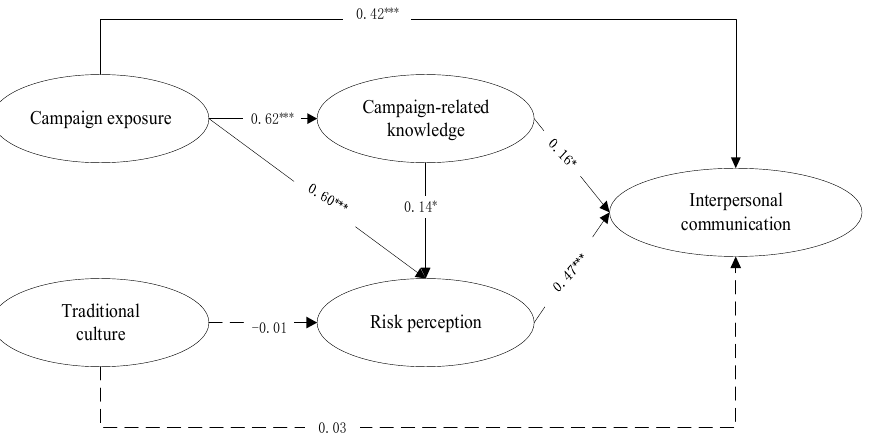
Figure 4. Results of hypothesis testing. Note: * p < 0.05 and *** p < 0.001.